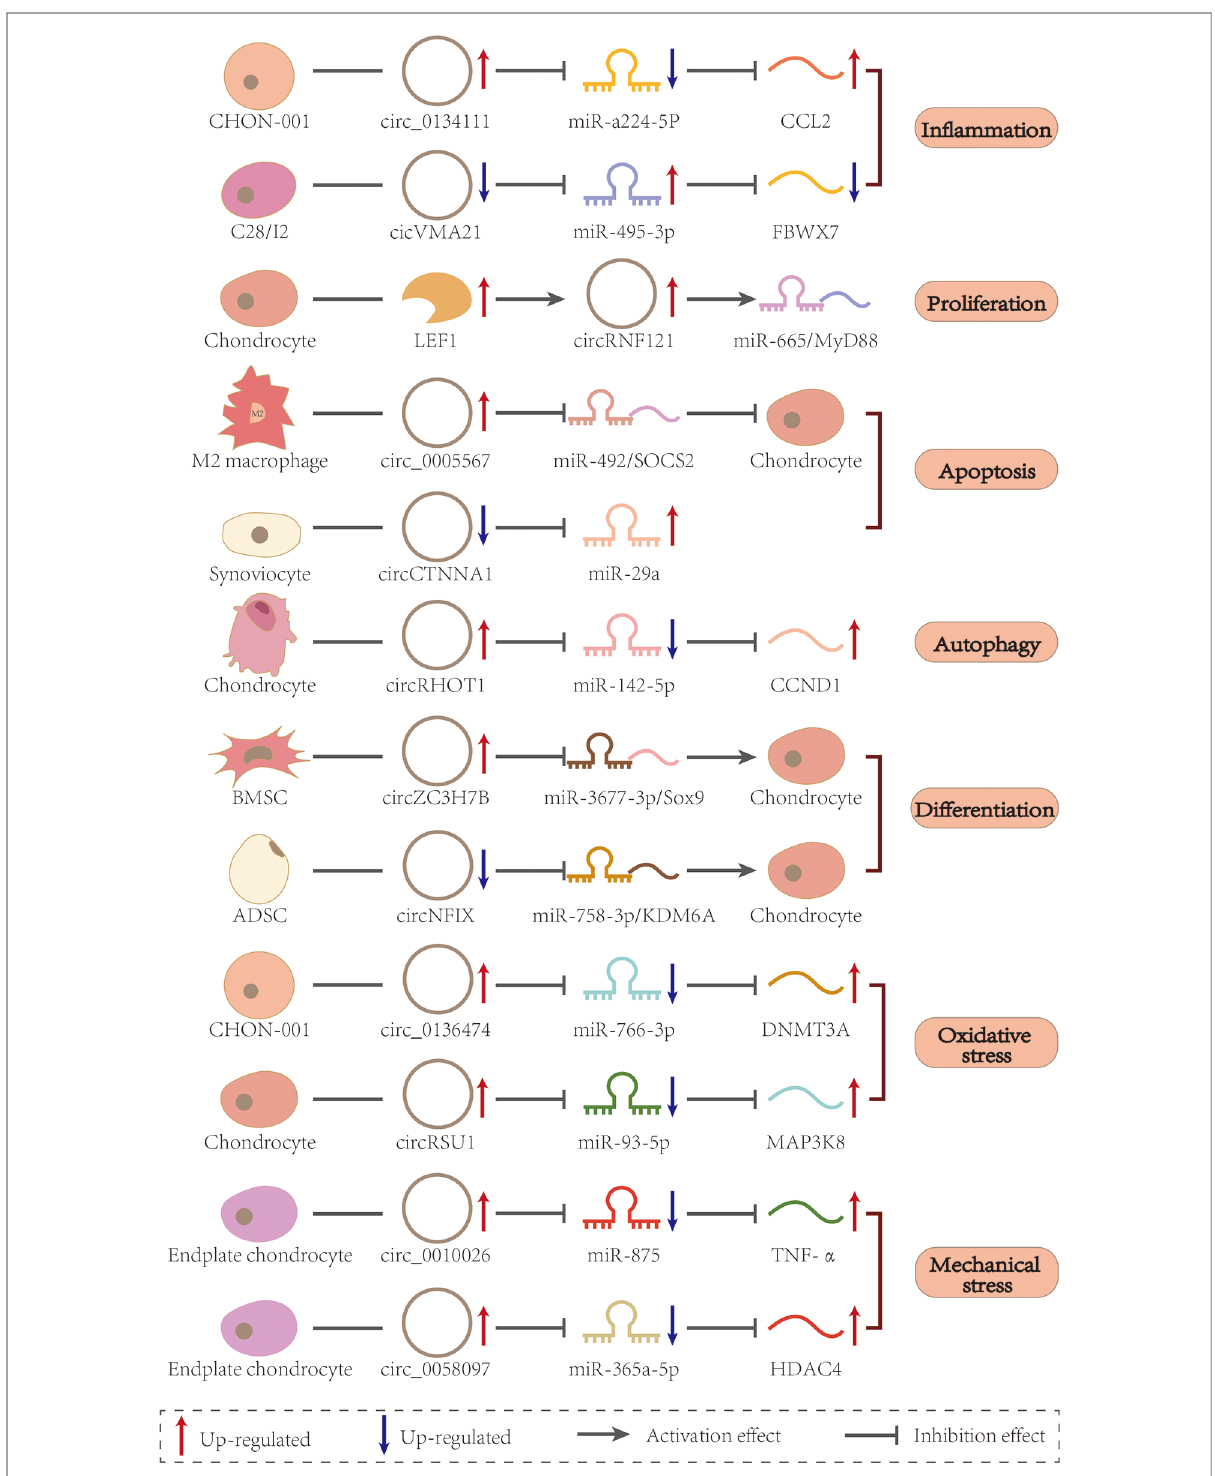
FIGURE 3 CircRNAs in different cells regulate miRNAs and mRNAs via the ceRNA mechanism. Each of the four types of arrows has a different meaning, as shown in the label at the bottom of the fi